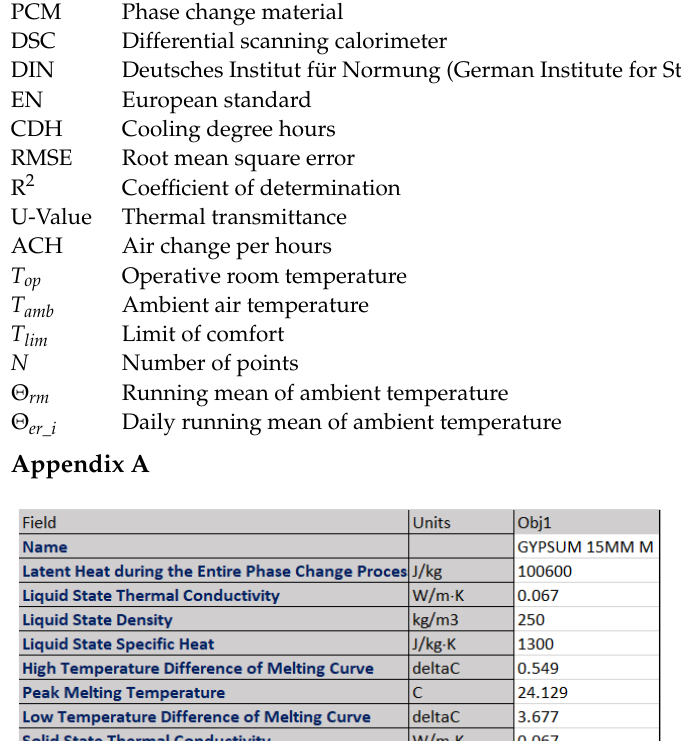
Table A2. Thermal properties of construction elements: classroom. Values obtained from Ubakus online calculator [52]. Construction